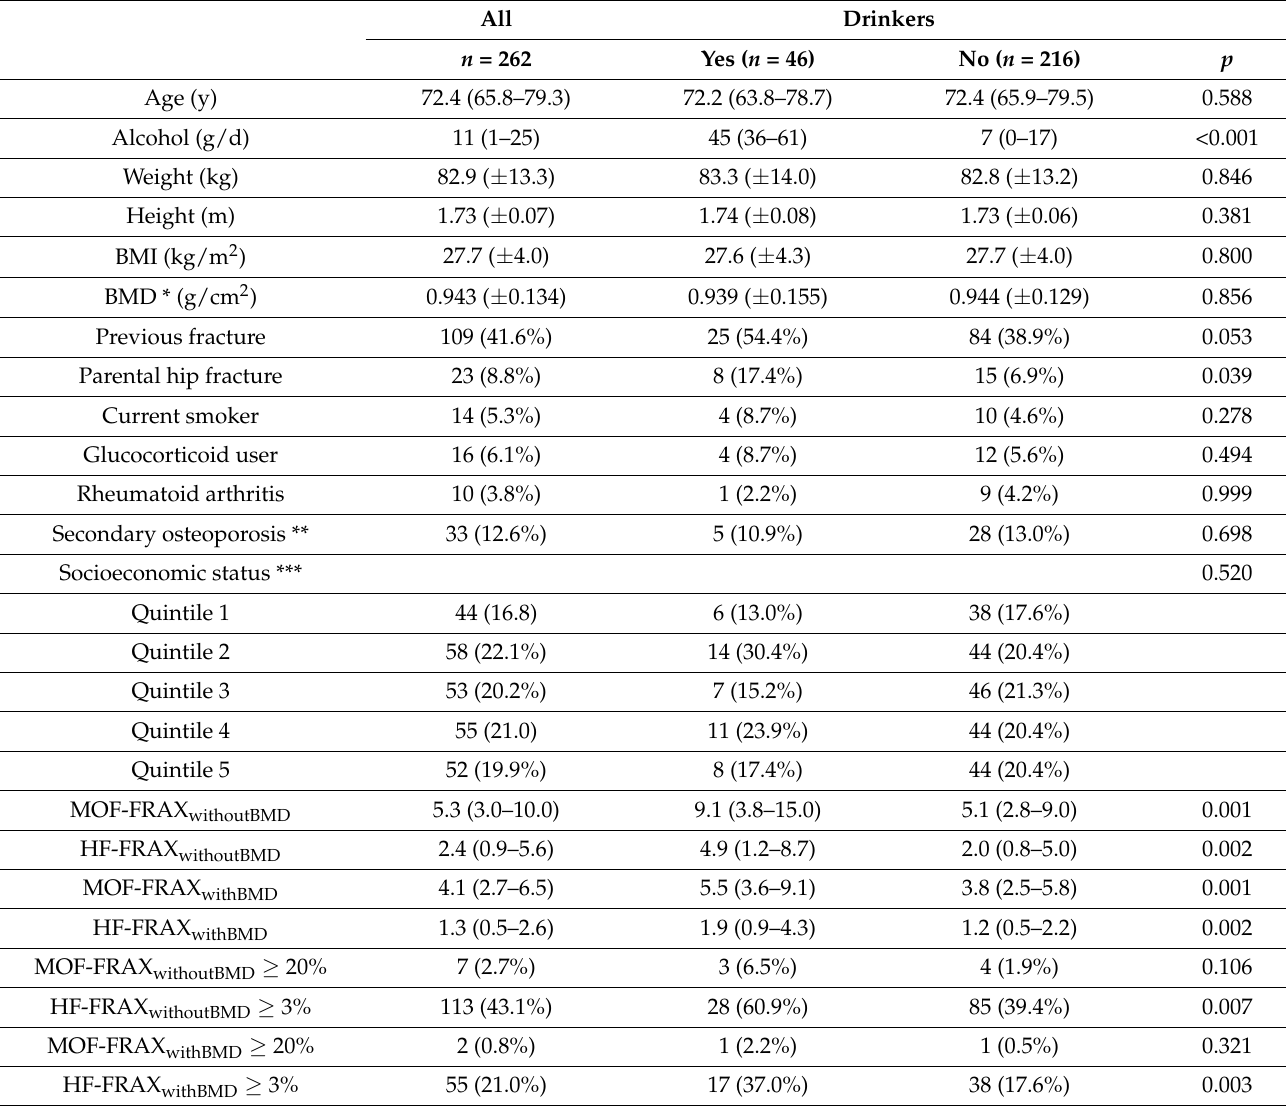
Table 1. Participant characteristics for the whole group and according to alcohol consumption (drinkers ≥ 3 and non- drinkers < 3 units alcohol/d). Data are shown as mean ( ± SD), median (interquartile range), or n (%).